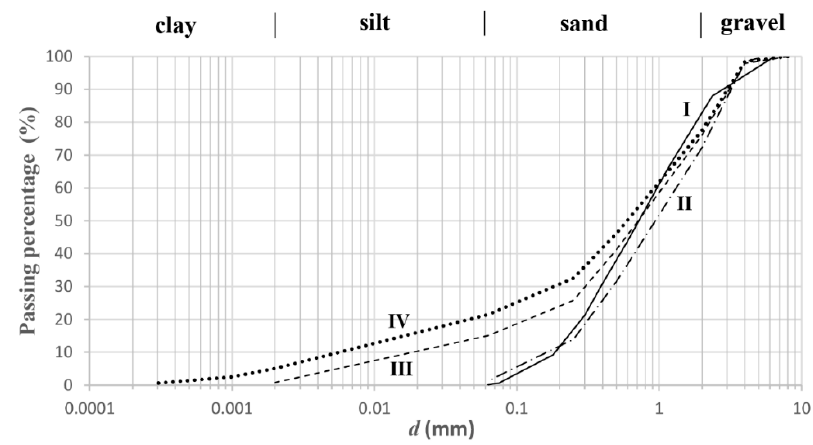
Figure 3. Granulometric curves of the four types of porous media considered.